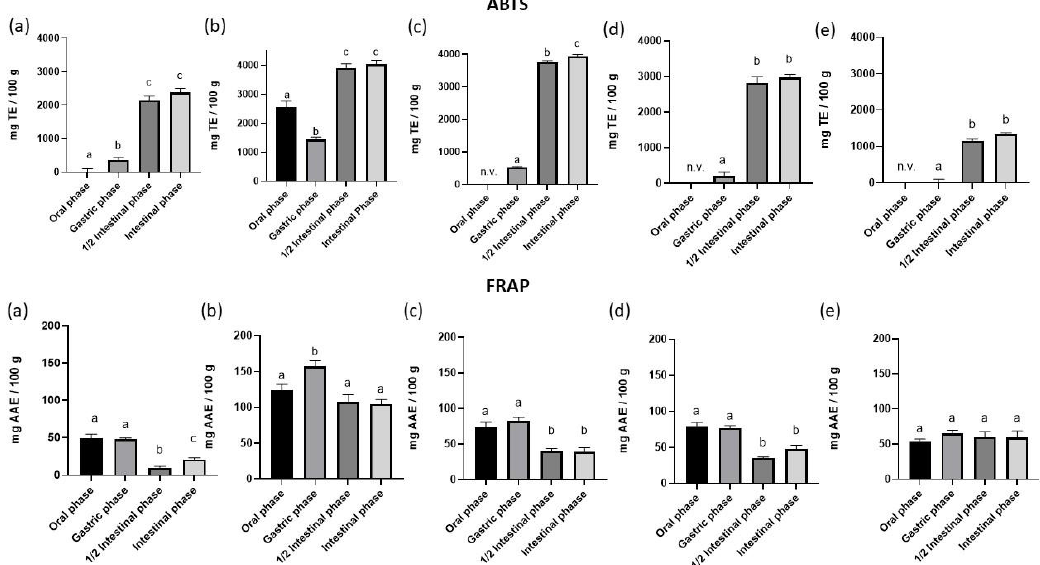
Figure 2. Antioxidant activity (ABTS and FRAP) of in vitro digestion. TE: trolox equivalent; AAE: ascorbic acid equivalent. Data are presented as mean ± standard error of mean (SEM). ( n = 3). Different superscript letters in columns indicate significant different data ( p < 0.05). ( a ) hempseeds; ( b ) flowers; ( c ) hempseed protein extract; ( d ) soy protein extract; and ( e ) flaxseeds. End of oral phase, end of gastric phase, ½ intestinal phase, and end of intestinal phase. n.v.: not valuable.